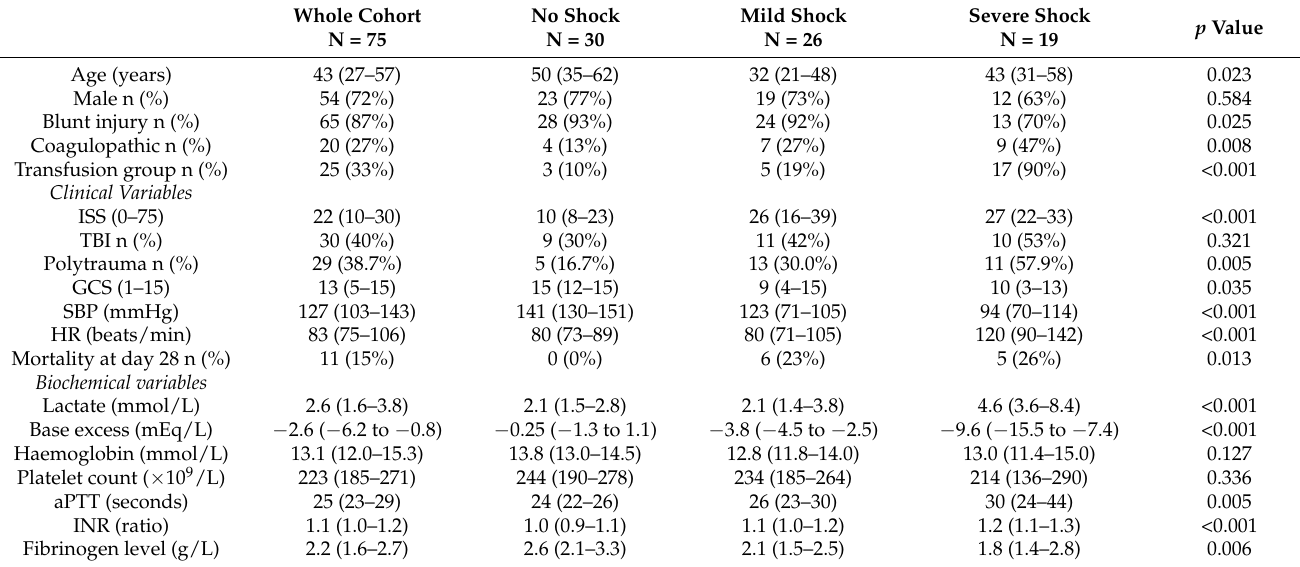
Table 1. Baseline demographics of the whole cohort and patients stratified according to shock severity.